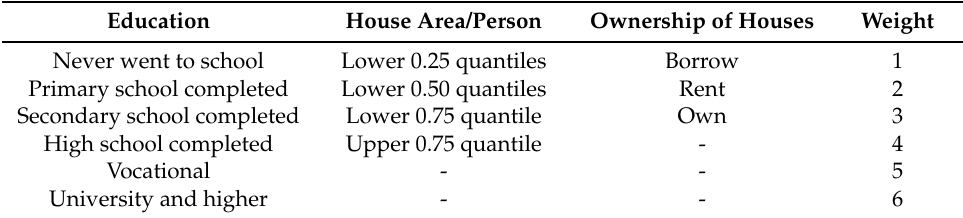
Table 7. Rank scale of socioeconomic